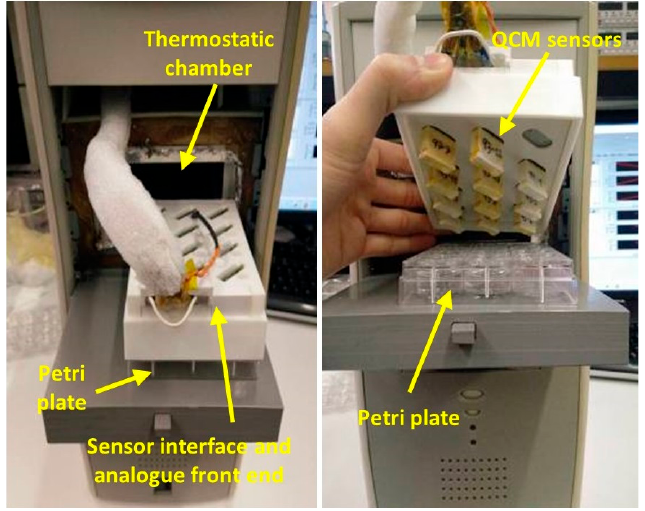
Figure 3. Array of QCM sensors, thermostatic chamber, and multi-well Petri plate.